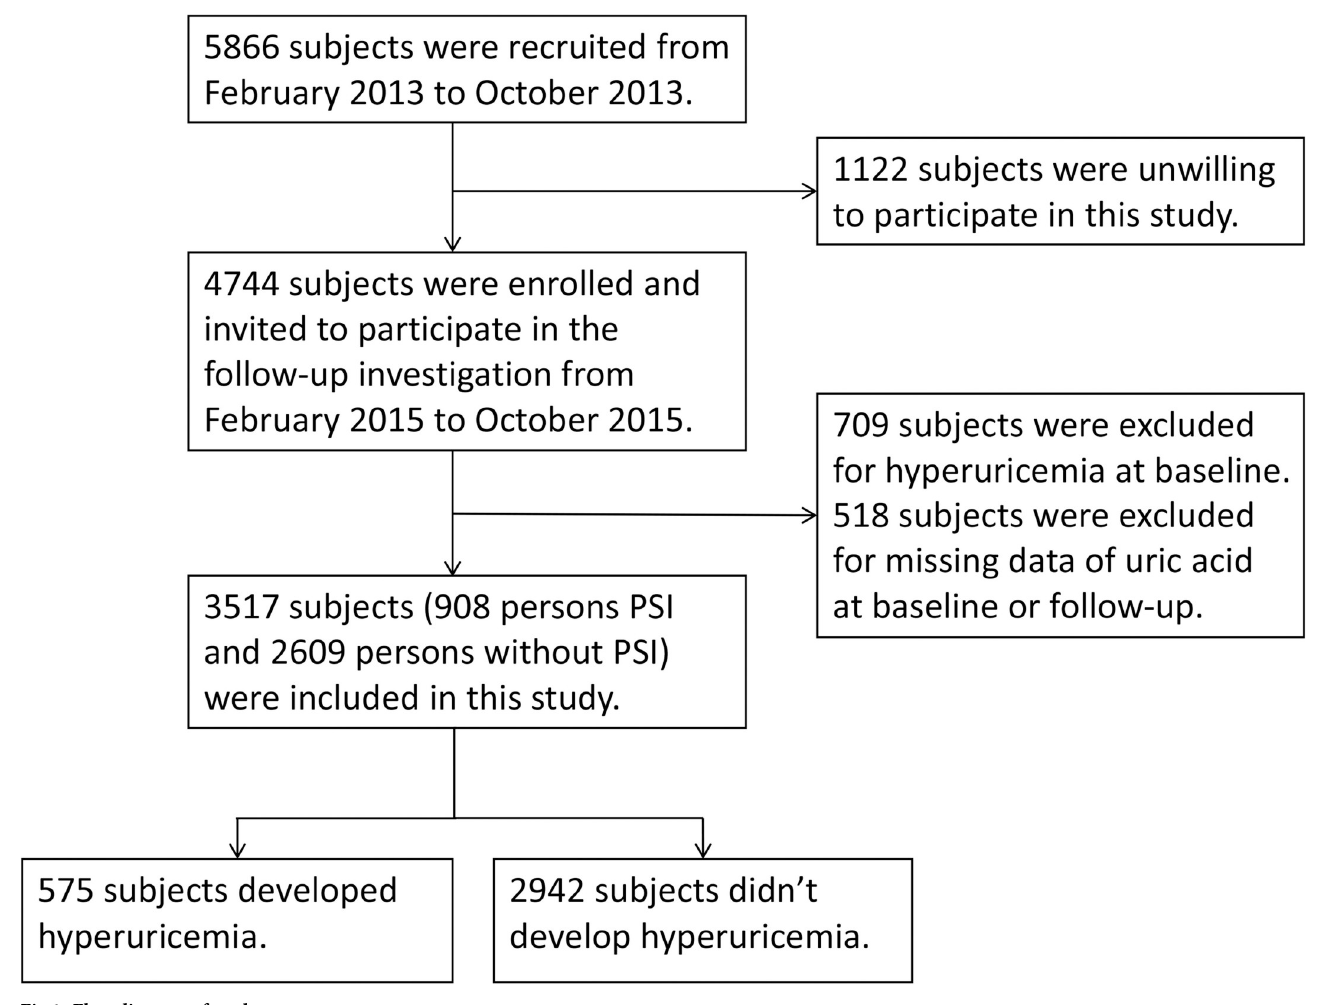
Fig 1. Flow diagram of